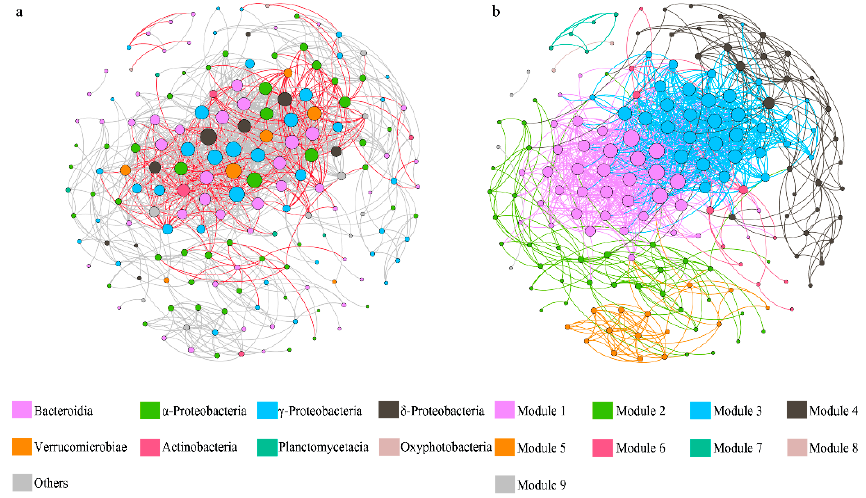
Figure 5. Co-occurrence network with ASVs colored by taxonomy ( a ) and modularity ( b ), respectively. The size of each node is proportional to the number of connections. Each connection has a Spearman’s correlation coefficient > |0.8| and a p -value < 0.01. A grey edge in ( a ) indicates positive interaction, while a red edge indicates negative interaction.